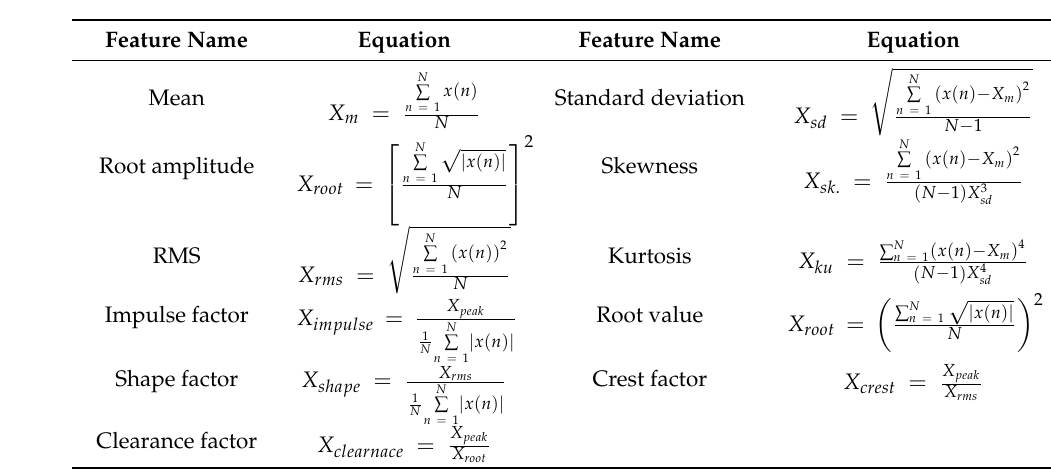
Figure 4. Features extraction and features vector in the time and frequency domains. Table 2. Time domain features of AE channels [19].